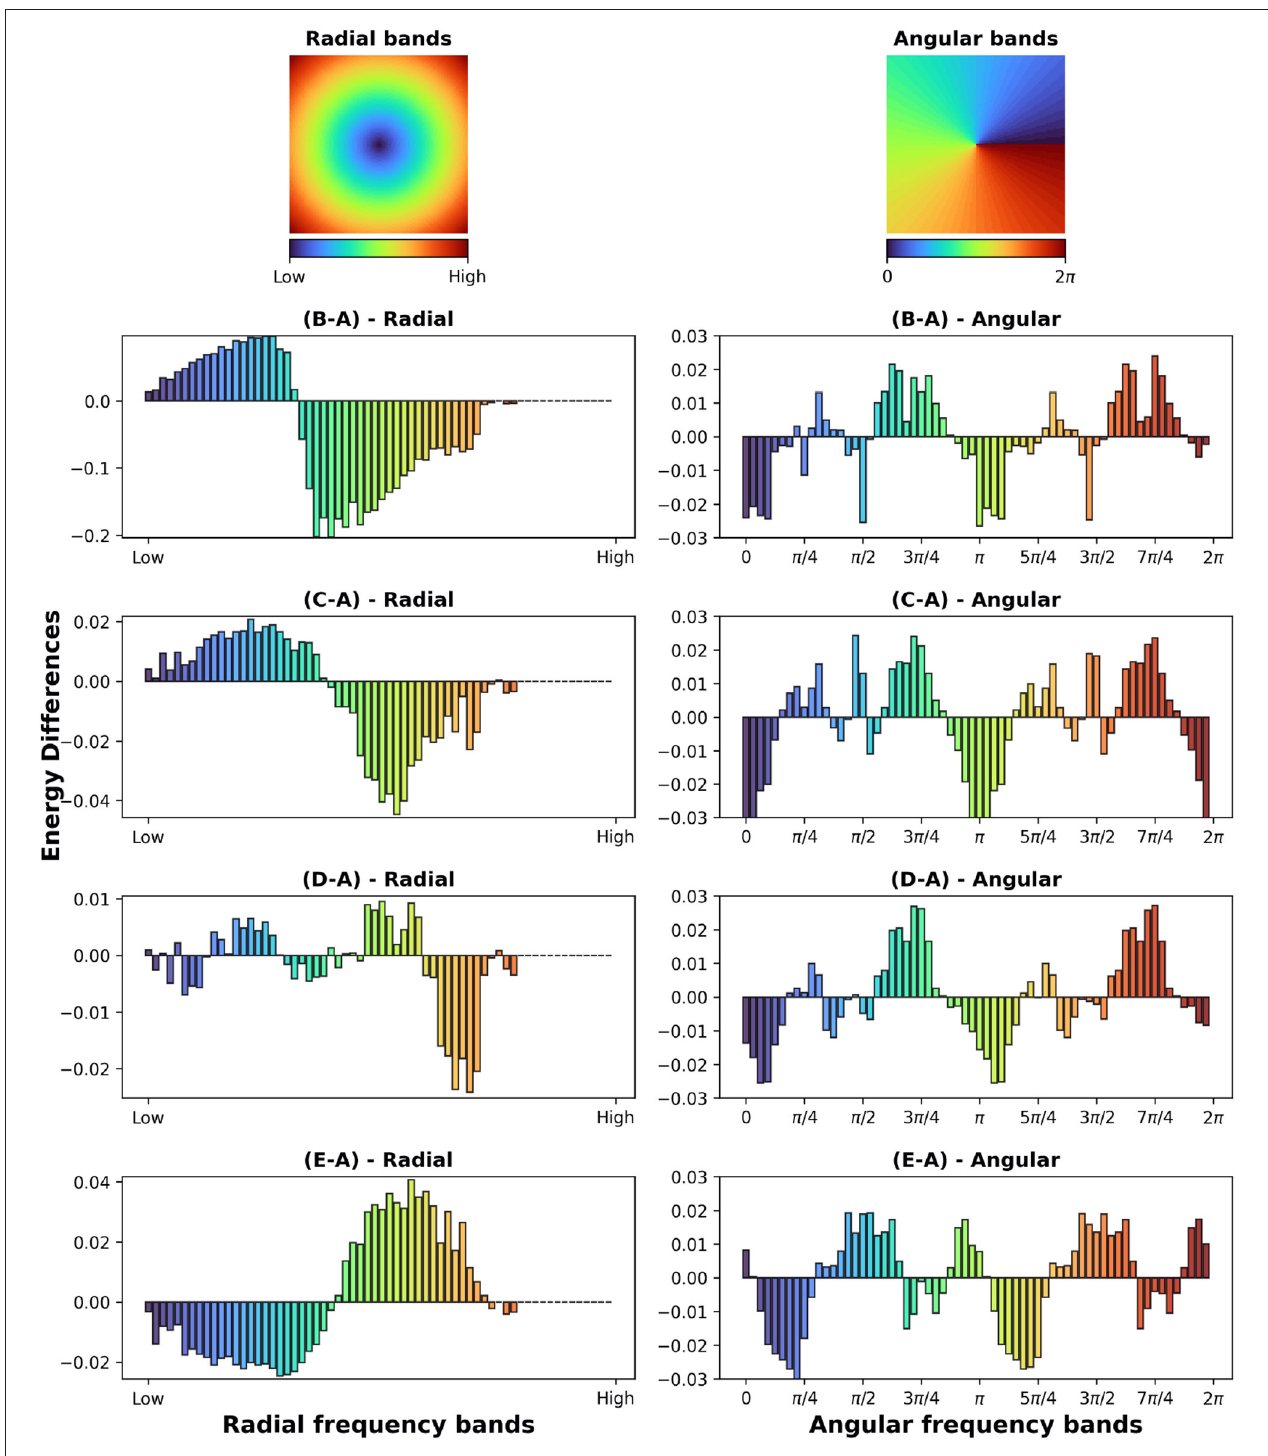
FIGURE 4 | (First row) Radial and angular partitions of the Fourier domain; Energy differences (B-A, C-A, D-A, E-A) in radial and angular directions for the augmentations in Figures 3(B–E) .